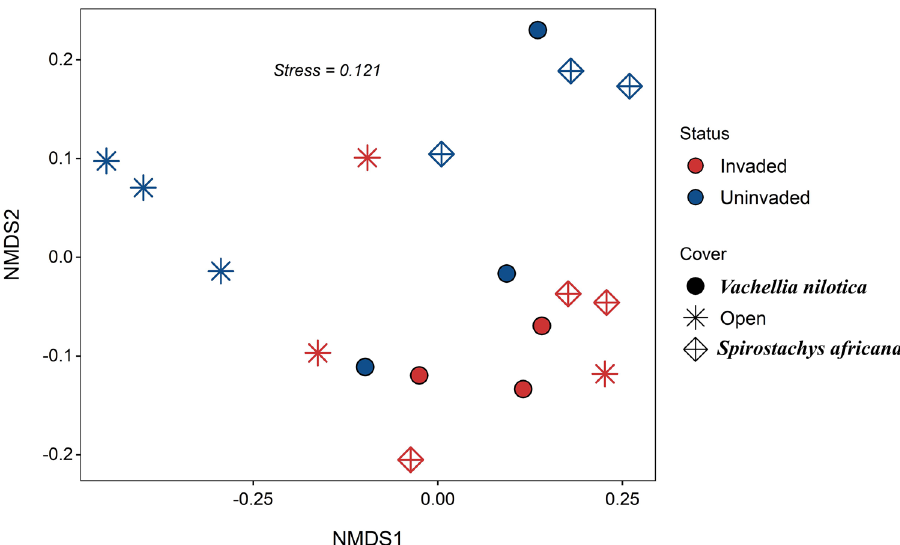
Figure 3. Non-metric Multidimensional Scaling (NMDS) plot for soil bacterial communities for various invasion (Invaded, Uninvaded) and tree cover ( V. nilotica , S. africana , none) categories. PERMANOVA results confirmed the significant effects of both cover and invasion status on bacterial community composition. The relatively low stress coefficient indicates good ordination with no risk of drawing false inferences 89